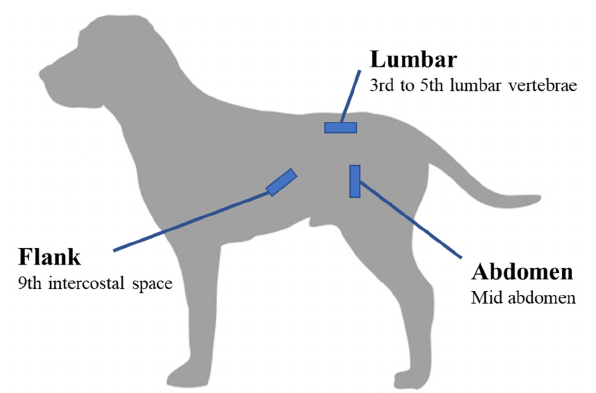
Figure 1. Schematic representation of the three anatomical sites used in the study to evaluate sub- cutaneous fat thickness in Labradors using real-time ultrasonography ( n = 88,